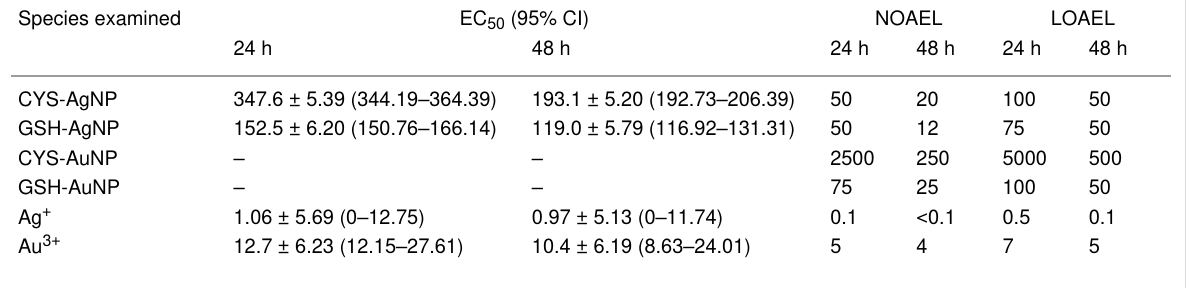
Table 2: Acute toxicity of ionic silver and gold, silver (AgNPs) and gold nanoparticles (AuNPs) stabilized with cysteine (CYS) or glutathione (GSH), to Daphnia magna Straus. EC 50 values, no adverse observed adverse effect levels (NOAEL) and lowest observed adverse effect levels (LOAEL) are given in µg Ag or Au L − 1 and expressed as mean values obtained from 6 experiments and include standard deviations, while 95% confidence inter- vals are given in